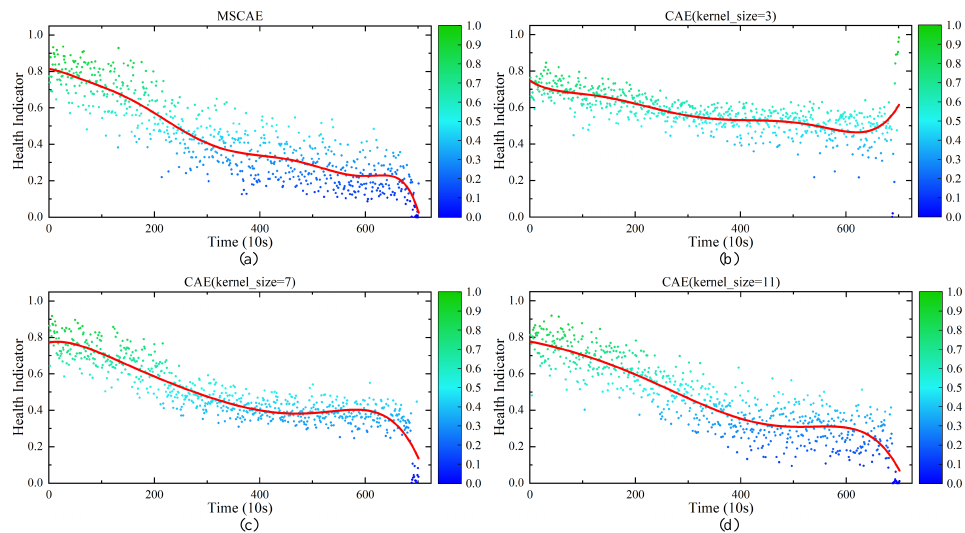
Figure 11. Four models to extract HI of Bearing2_6. ( a ) MSCAE. ( b ) CAE (kernel_size = 3). ( c ) CAE (kernel_size = 7). ( d ) CAE (kernel_size =